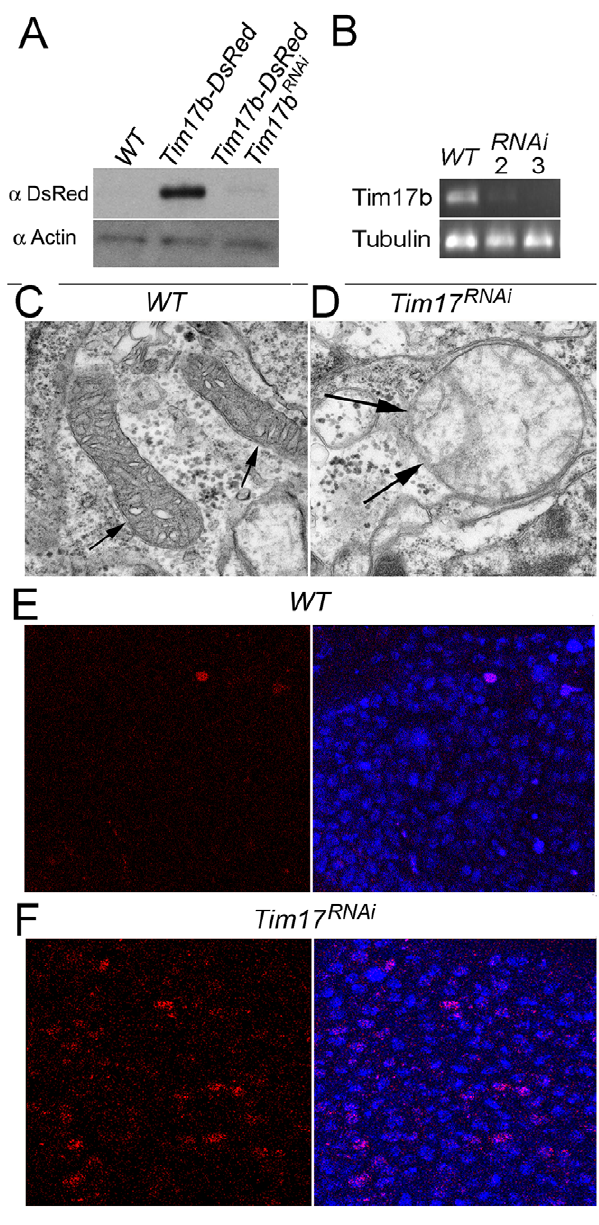
Figure 3. Expression of Tim17b RNAi transgene disrupts Tim17b protein production. A. Co-expression of Tim17b-DsRed recombinant protein with Tim17b RNAi eliminates Tim17b-DsRed protein production. Western blot hybridization was used to compare the amount of Tim17b-DsRed protein in Gal4 69B; UAS-Tim17b-DsRed and Gal4 69B; UAS-Tim17b-DsRed; UAS-Tim17b RNAi larvae. Anti-Actin antibody was used as a loading control. B. Expression of Tim17b RNAi disrupts intrinsic Tim17b mRNA production. RT-PCR using intrinsic Tim17b-specific primers demonstrates that accumulation of Tim17b mRNA is abolished in Tim17b RNAi -expressing animals. The numbers 2 and 3 indicate age of animals collected for analysis after egg laying. Primers specific to Tubulin mRNA were used as a loading control. C – D. Expression of Tim17b RNAi disrupts mitochondria. The structure of wild-type mitochon- dria detected by TEM ( C ) is affected in Tim17b RNAi -expressing animals ( D ). Arrows indicate mitochondria. E – F. Expression of Tim17b RNAi increases apoptosis in larval brain. WT – wild- type first-instar larvae ( E ). Tim17b RNAi -expressing first-instar larvae ( F ). Dissected larval brains were stained using ApopTag (red), which detects apoptotic cells. DNA visualized using OliGreen dye (blue).